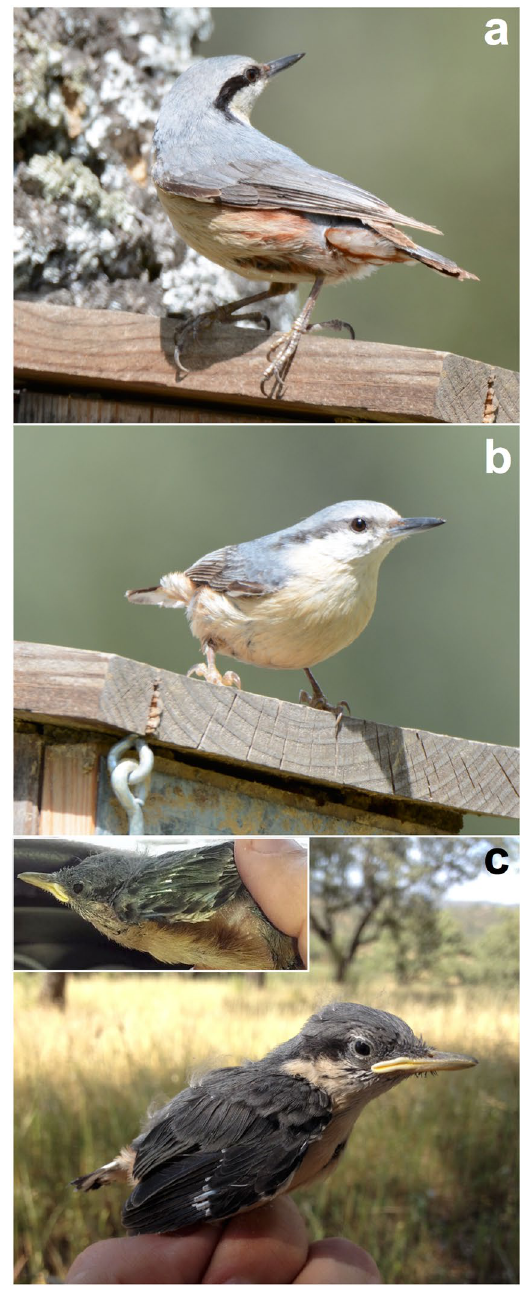
Figure 1. Photographs of Eurasian nuthatches from the study area. ( a ) Adult male showing chestnut feathers colored by pheomelanin in the flank, breast and undertail. ( b ) Adult female. ( c ) Male nestling (insert photographs show details of flank feathers). Credits: Ismael